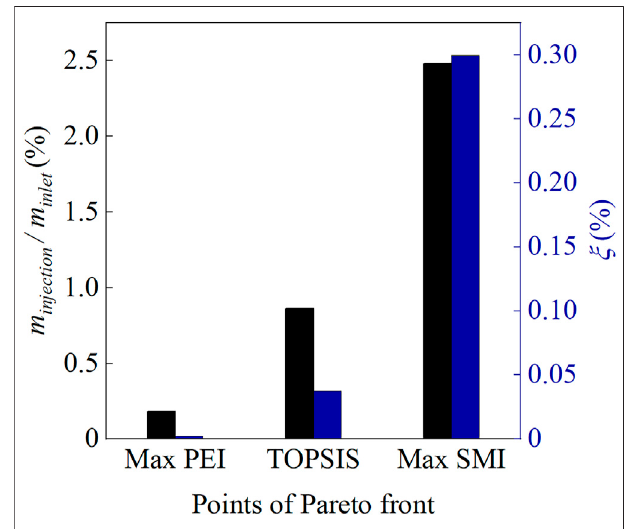
FIGURE 13 | Comparisons of the injection fl ow rate and the loss of different design